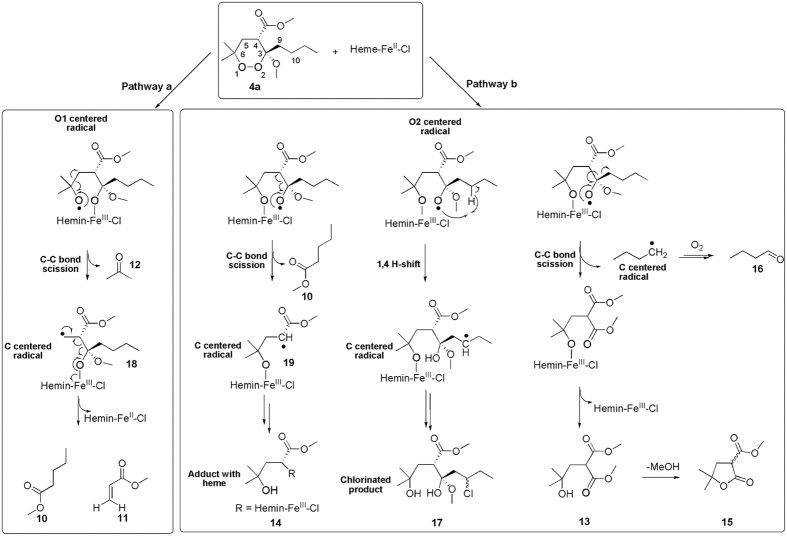
Proposed reaction mechanism of the synthetic analog 4a with heme-FeII-Cl.